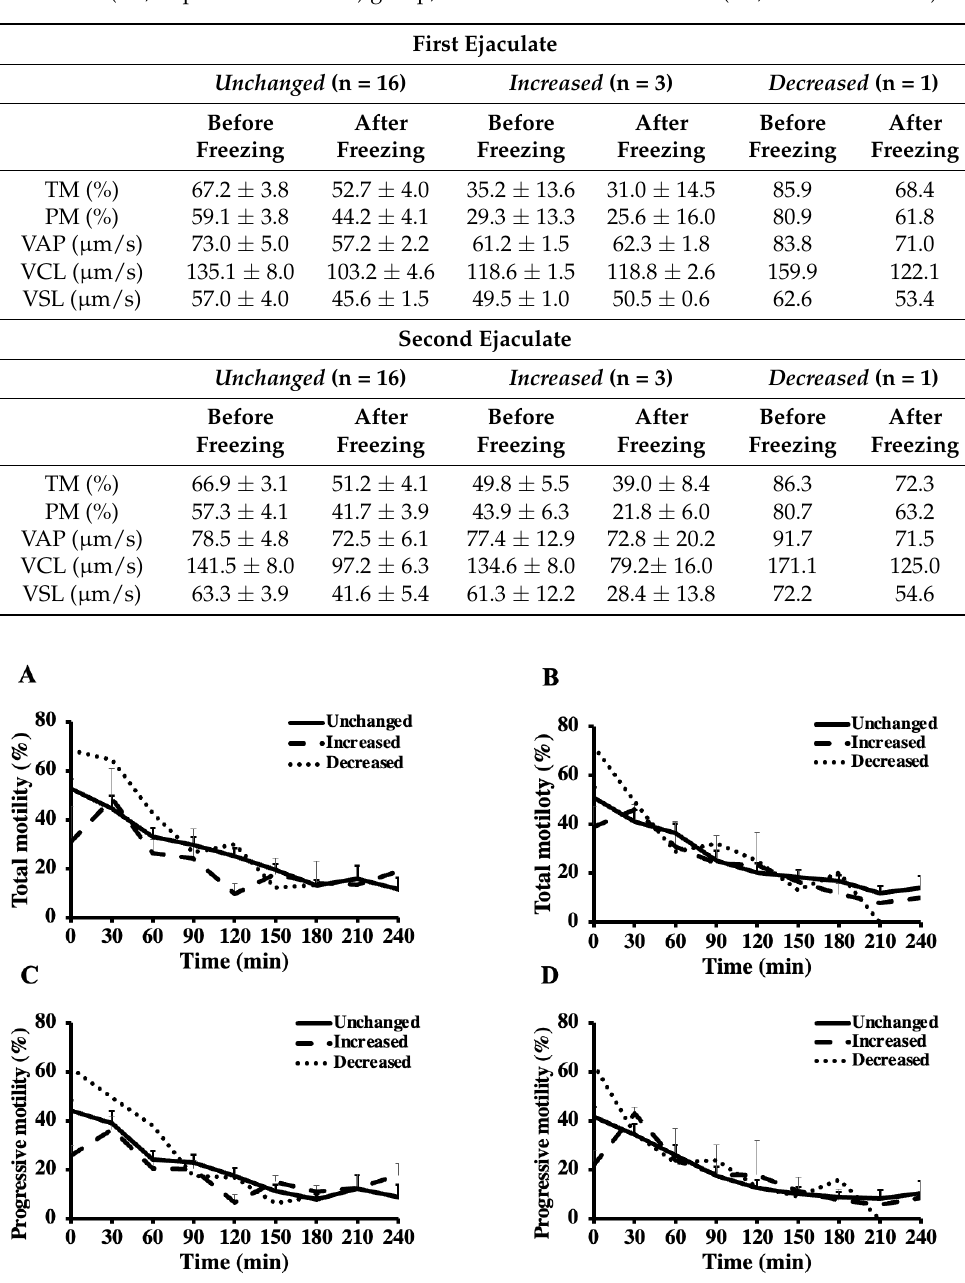
Figure 4. Total ( A , B ) and progressive ( C , D ) motility of the first ( A , C ) and second ( B , D ) ejaculates from breeding inactive stallions (n = 20) during a thermal longevity test. The frozen-thawed semen was incubated at 37 °C for 240 min. Based on the motility parameters between the first and second ejaculates, sixteen stallions were classified as unchanged (i.e., ≤10% change), three stallions as increased (i.e., improvement > 10%) group, and one stallion as decreased (i.e., reduction > 10%).